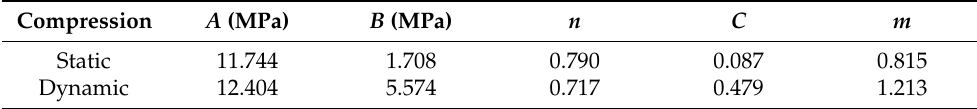
Table 1. JC model parameter sets with 0.1% strain